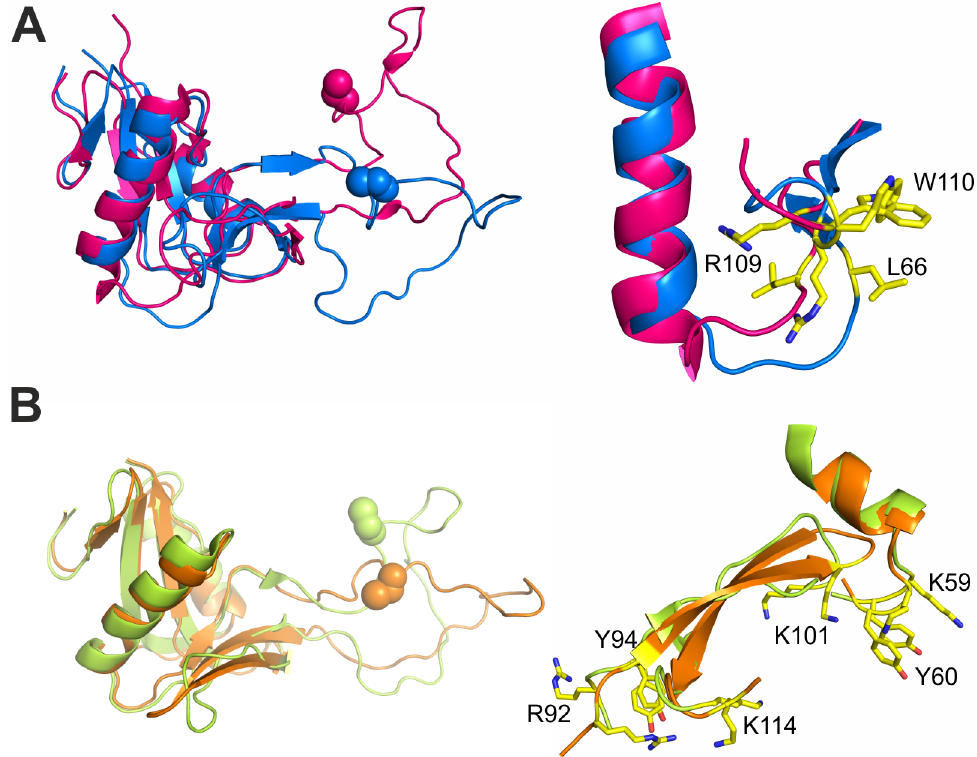
Fig 6. An overview of the RC γ and RC δ binding residues, depicting the local conformational changes that occur upon α 2A binding. ( A ) A comparisonof the RC γ subunit binding site (L66/R109/W110) betweenthe RC αβγδ (purple)and RC γδ - α 2Acomplex (blue) structures. Due to the globalmovements within the index finger swappingdomainthat accompany the formation of the RC γδ - α 2A complex, a local repositioning of the key α 2A interacting residues within RC γ takes place such that they adopt an orientationthat is compatiblefor α 2A binding. ( B ) A comparison between the 2 RC δ subunit binding sites (K59/Y60/K101 and R92/Y94/K114) betweenthe RC αβγδ (yellow)and RC γδ - α 2Acomplex (orange)structures. In contrast to RC γ , all the RC δ residues involvedin α 2A bindingwouldbe in an α 2A-competent orientation in both the RC αβγδ (yellow) and RC γδ - α 2A complex (orange)structures, with the exceptionof R92, which forms an internalsalt bridgewith D74 γ in the RC αβγδ tetramer but interacts with D219 of α 2A in the RC γδ - α